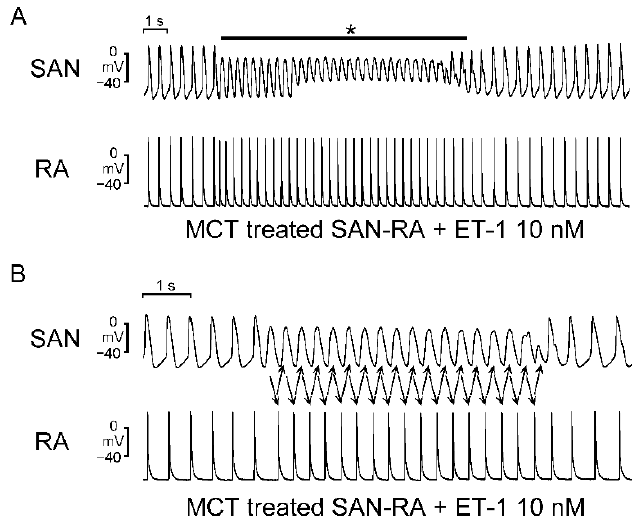
Figure 5. The electrical activities of endothelin (ET)-1-treated sinoatrial node (SAN)–right atrium (RA) preparations from monocrotaline (MCT)-treated rabbits were recorded by the conventional glass electrode. ( A ) A representative recording of short runs of atrial tachycardia (indicated by a black asterisk on top) in ET-1-treated SAN–RA preparations from MCT-treated rabbits. ( B ) Representative recordings revealed reentry as a mechanism of initiation of ET-1-induced short runs of atrial tachycardia in MCT-treated SAN–RA